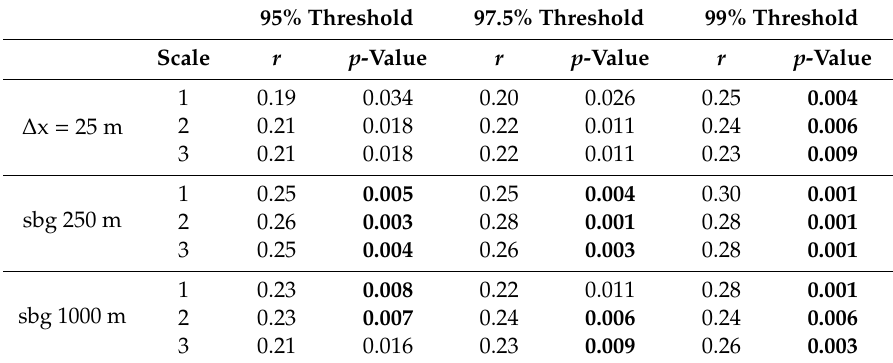
Table 2. Spearman rank correlation r and its p -value between the slope-related parameter µ and the wavelet variance of the inter-extreme time series of the wind extremes for di ff erent thresholds. The results below the significance level of 0.01 are in bold.